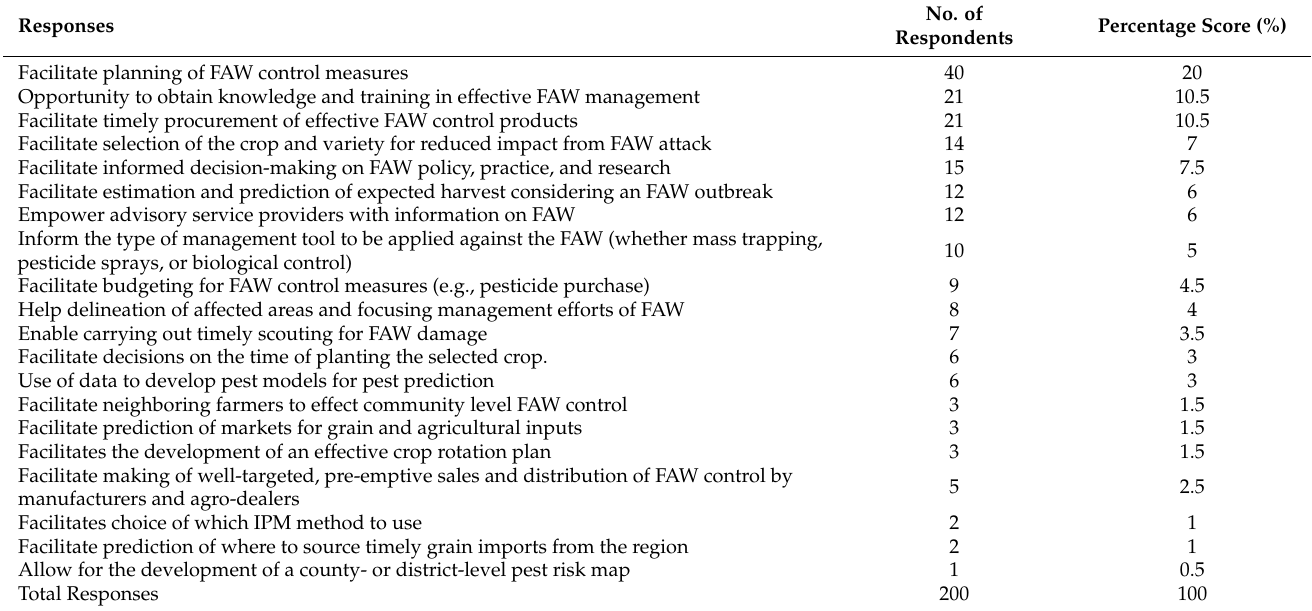
Table 2. Responses to freeform question to respondents regarding the benefits of an FAW outbreak prediction tool to their business or